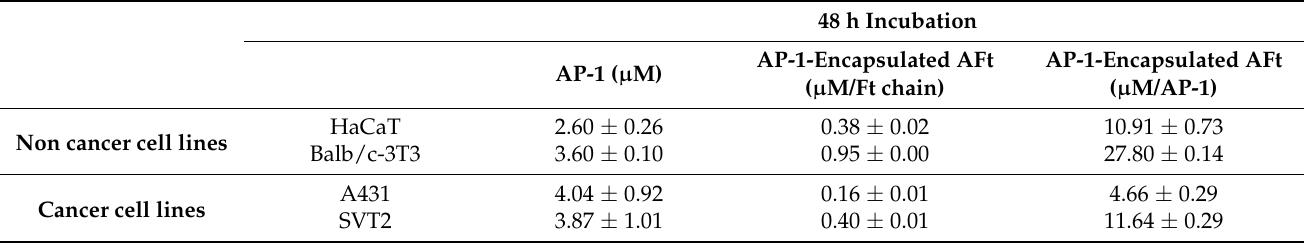
Table 1. IC 50 values obtained after 48 h of incubation with AP-1 and AP-1-encapsulated AFt based on the concentration of AP-1 and AFt, for on BALB/c-3T3, SVT2, and A431 cell